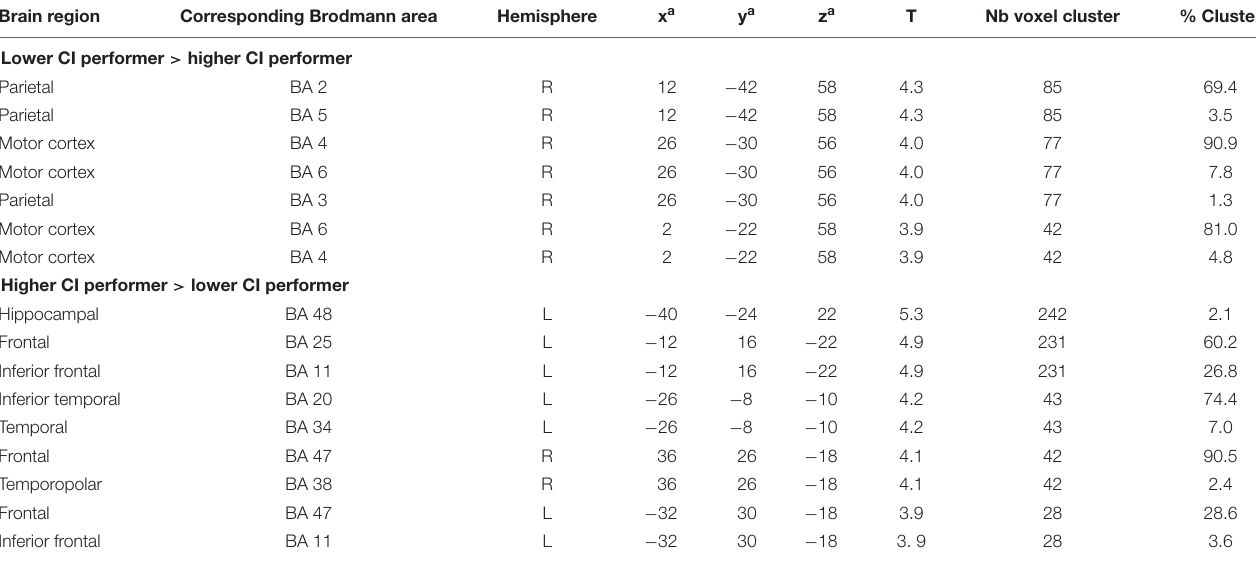
FIGURE 3 | Statistical parametric maps (SPMs) reflecting group differences between higher and lower cochlear-implant (CI) performers with regards to speech-related activation in the context of a semantic-anomaly paradigm. Relative perfusion increases (activations) due to performing the sentence discrimination task are shown. Note a pattern of a (A) prefrontal perfusion increase in lower compared to higher performers and (B) an increased occipital and parietal perfusion in higher compared to lower performers. TABLE 4 | Results of unpaired t -test comparing the rest condition image between cochlear-implant (CI) users with lower and higher speech comprehension (significance level used for inferences at a voxel level p < 0.001, extent voxel threshold k = 0). Brain